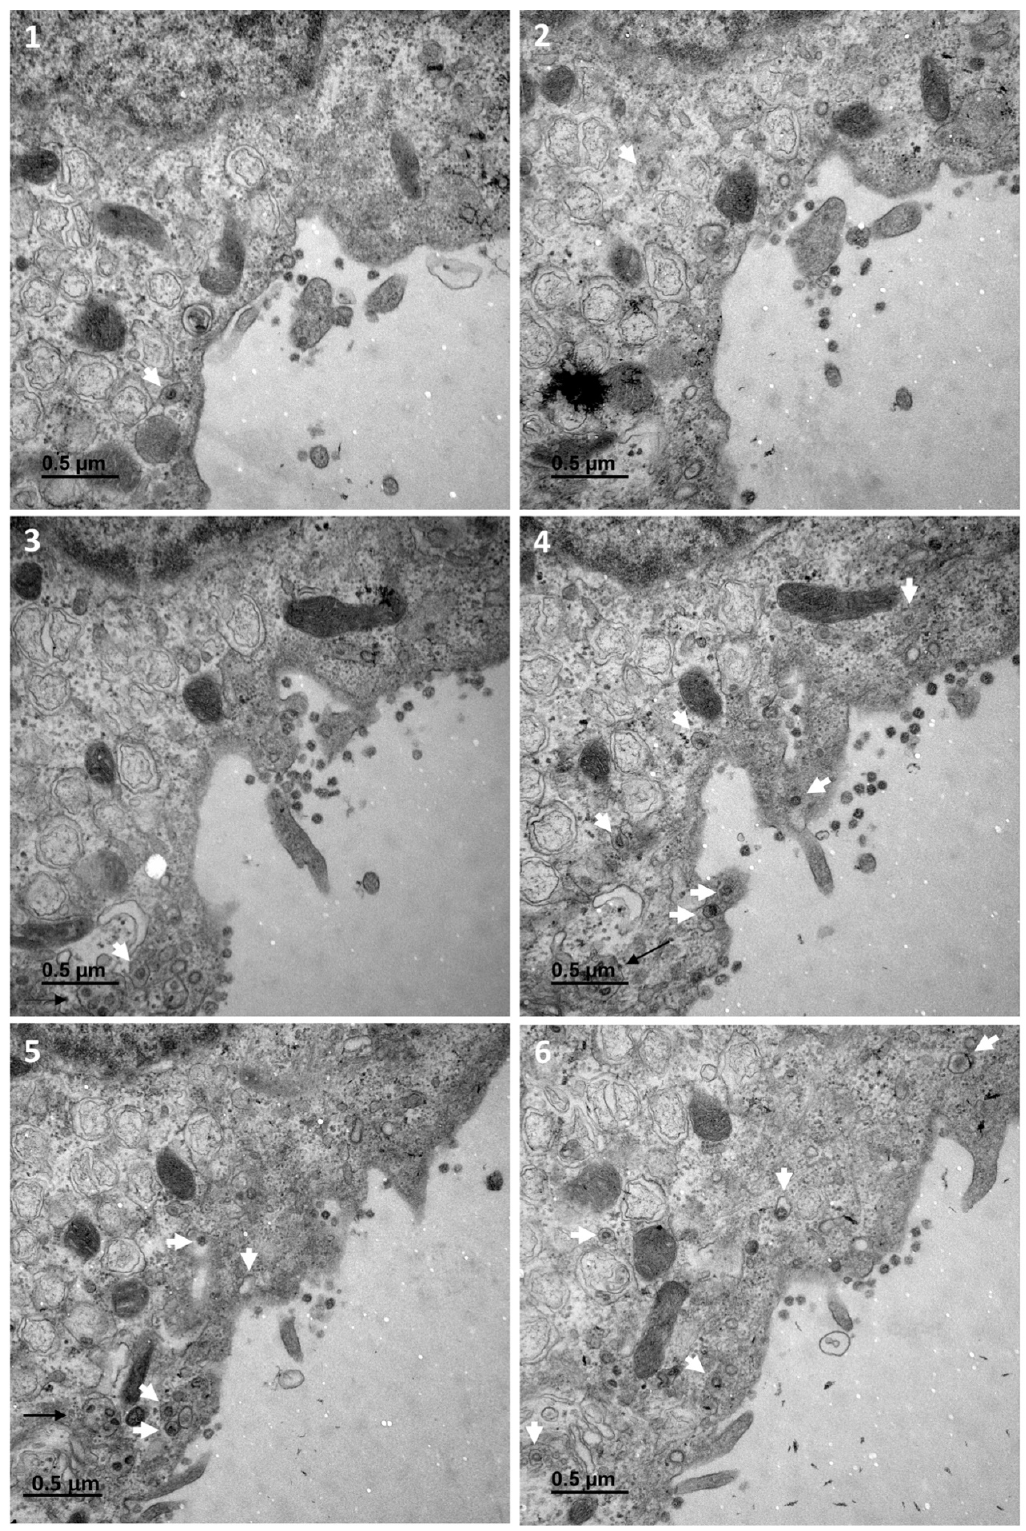
Figure 4. Serial TEM sections of cell A part 3, a region in which the situation is intermediate to those observed on part 1 and 2, with small plasma membrane microvilli at the cell surface. Large intracellular vesicles rich in viral particles (thin black arrows) and small vesicles each containing a single viral particle (large white arrows) are shown on each serial section. The high-resolution electron micrographs for this series can be consulted in the Supplementary Materials. The numbers on the panels ( 1 – 6 ) indicate the successive serial TEM sections.